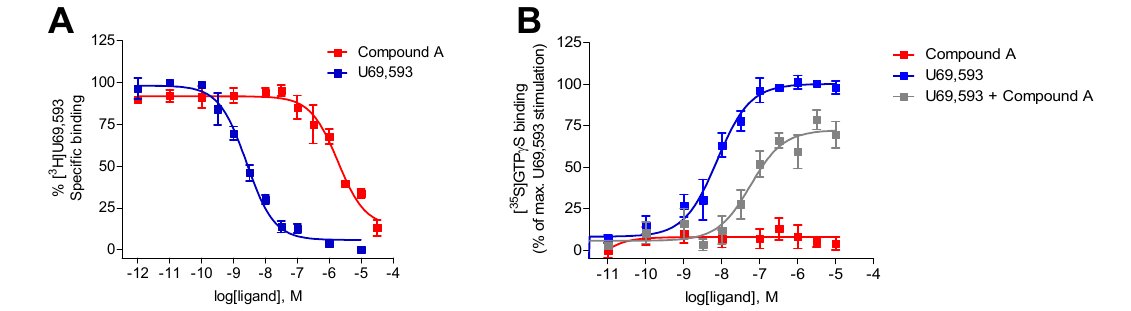
Figure 3. In vitro activity profile of Compound A at the human KOR. ( A ) Concentration-dependent inhibition by Compound A and U69,593 of [ 3 H]U69,593 binding to membranes from CHO-hKOR cells determined in radioligand competitive binding assays. ( B ) Concentration-dependent stimulation of [ 35 S]GTP γ S binding by Compound A and U69,593, and effect of Compound A on U69,593-stimulated [ 35 S]GTP γ S binding to membranes from CHO-hKOR cells determined in the [ 35 S]GTP γ S binding assays. Values represent means ± SEM of at least 3 independent experiments performed in duplicate.